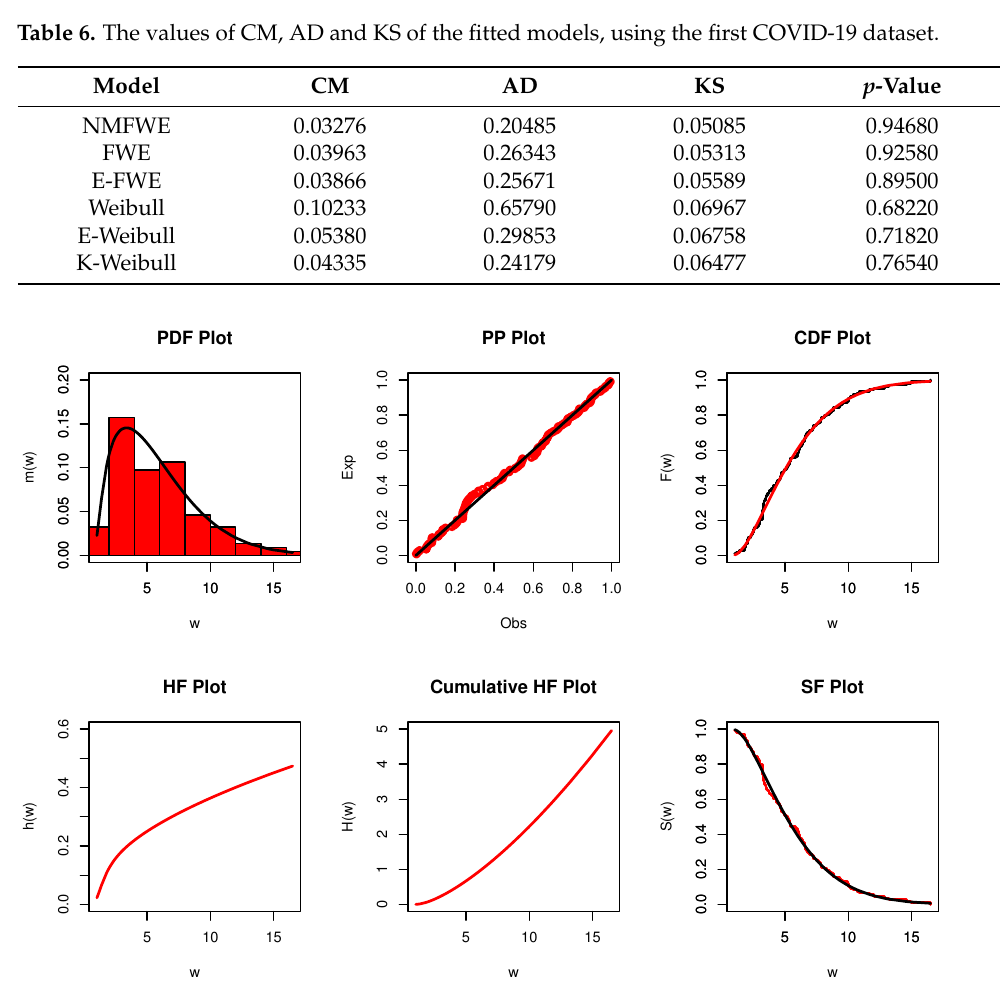
Figure 6. A visual illustration of the NMFWE model using Data 1. For Data 2, the numerical values of ˆ σ 1 , ˆ σ 2 , ˆ λ , ˆ β 1 , and ˆ β 2 are provided in Table 7. For this data, the values of the analytical tools are presented in Tables 8 and 9. From the numerical comparison of the competing distributions in Tables 8 and 9, we observe that the proposed NMFWE model is the best choice to implement for dealing with the mortality rate data. For the NMFWE distribution, the values of the analytical measures are AIC = 848.33910, CAIC = 848.44800, BIC = 858.57400, HQIC = 852.47040, CM = 0.03762, AD = 0.21668, and KS = 0.04217, with p -value = 0.82040. The second-best model, based on the KS test with p -value, is the K-Weibull distribution, with the respective values given by 0.04345 and 0.79130. By considering the other analytical tools, we observe that the E-FWE model is the second-best